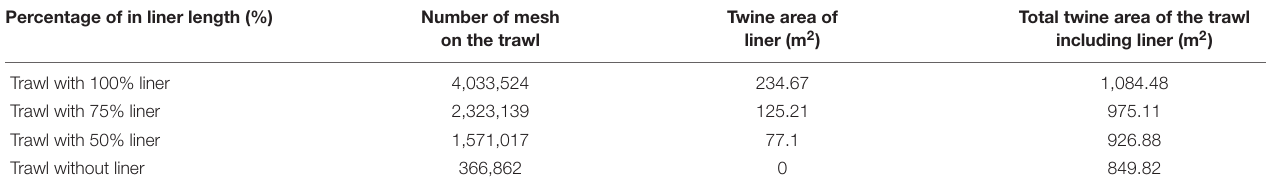
TABLE 2 | Total number of mesh and twine area for trawl net and liner in full scale. Percentage of in liner length